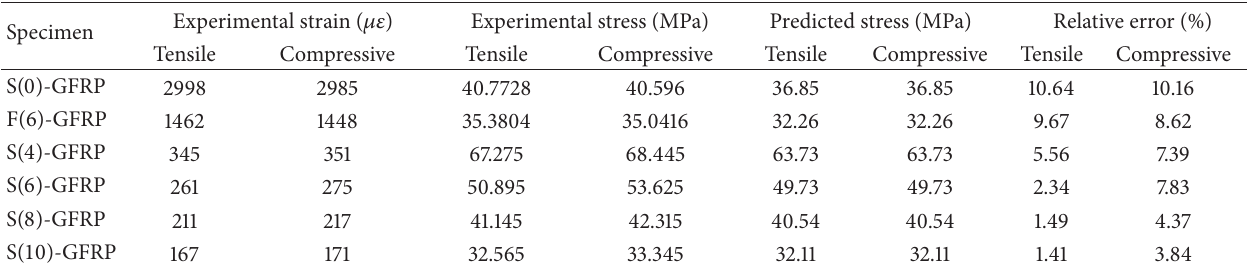
Figure 14: Sectional stress distribution at mid-span for specimen S( 8 )-GFRP: (a) normal stress and (b) shear stress (unit in MPa). Table 4: Comparisons of maximum tensile and compressive stress between experimental and analytical results.